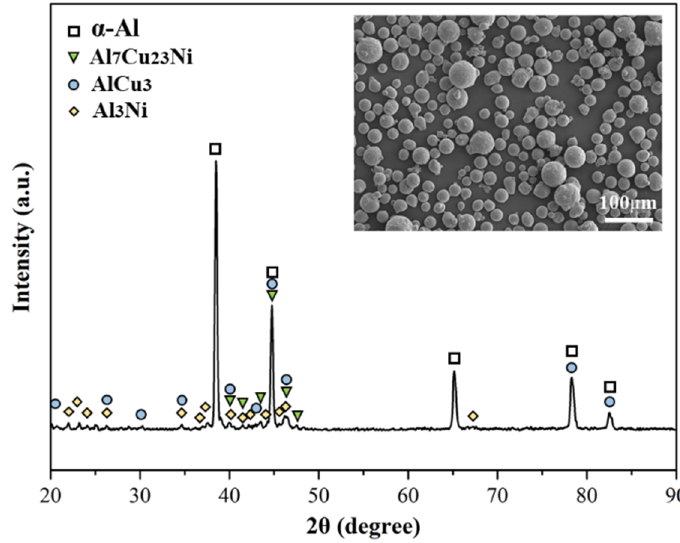
Figure 1. SEM and XRD analysis of the Al-Ni-Cu alloy powders.